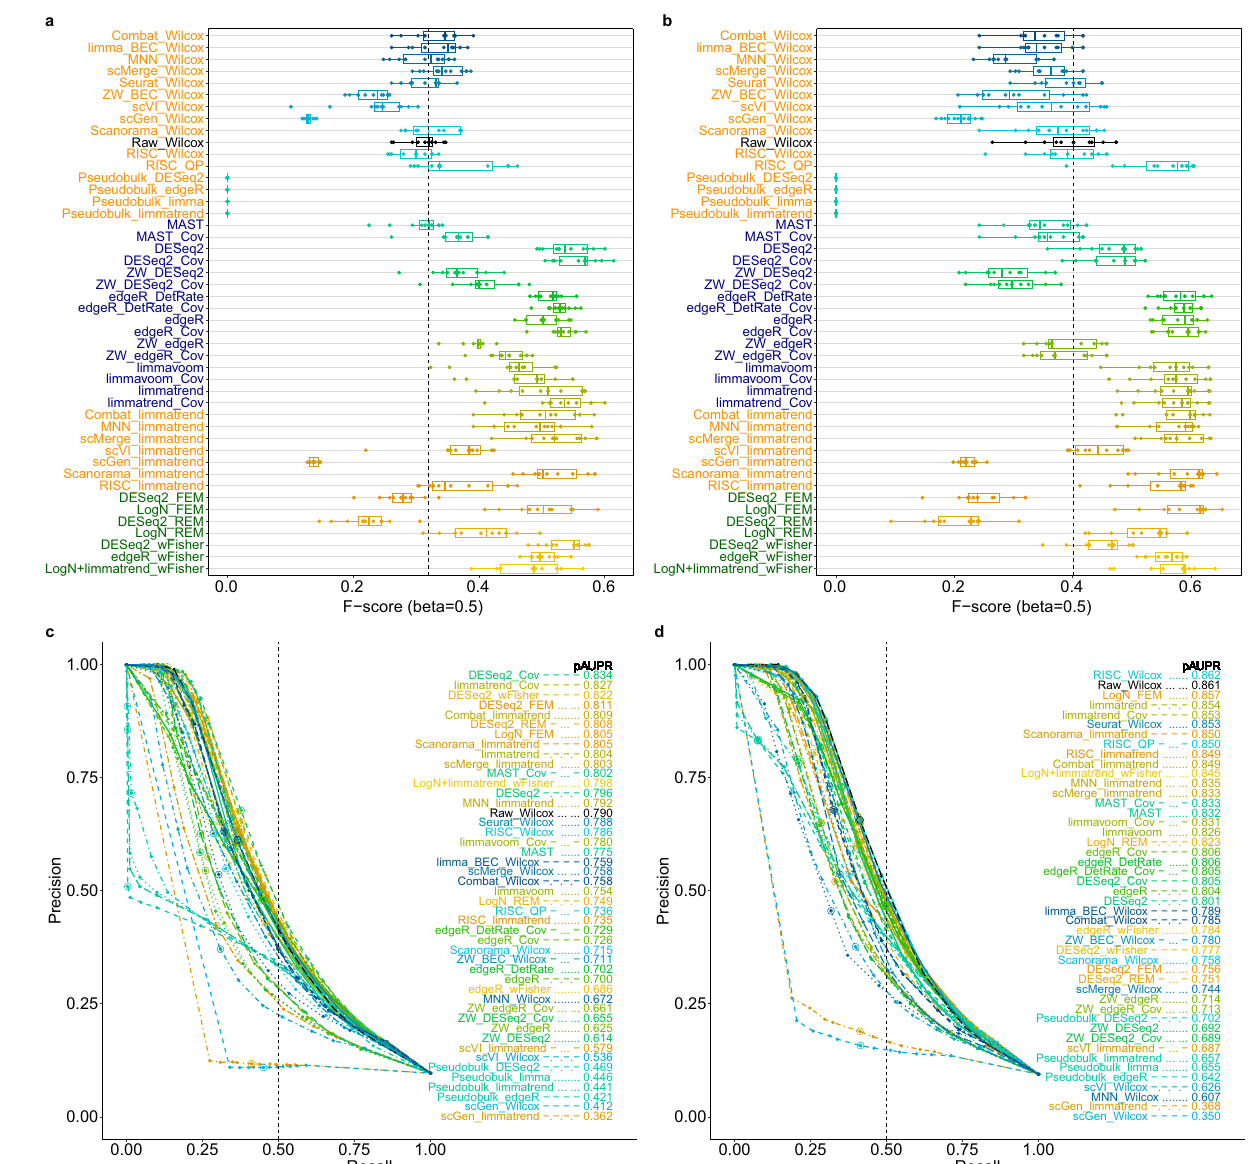
Fig. 3 | Model-based simulation results for low depths (depth-10 and depth-4; zero rate >80%). F 0.5 -scores for 46 differential expression (DE) work fl ows for ( a ) depth-10 and ( b ) depth-4. Results for six cell proportion scenarios (12 instances in total: six for upregulated genes and six for downregulated genes) are represented as boxplots; the lower, center and upper bars represent the 25th, 50th and 75th percentiles,respectively,andthewhiskersrepresent±1.5×interquartilerange.The